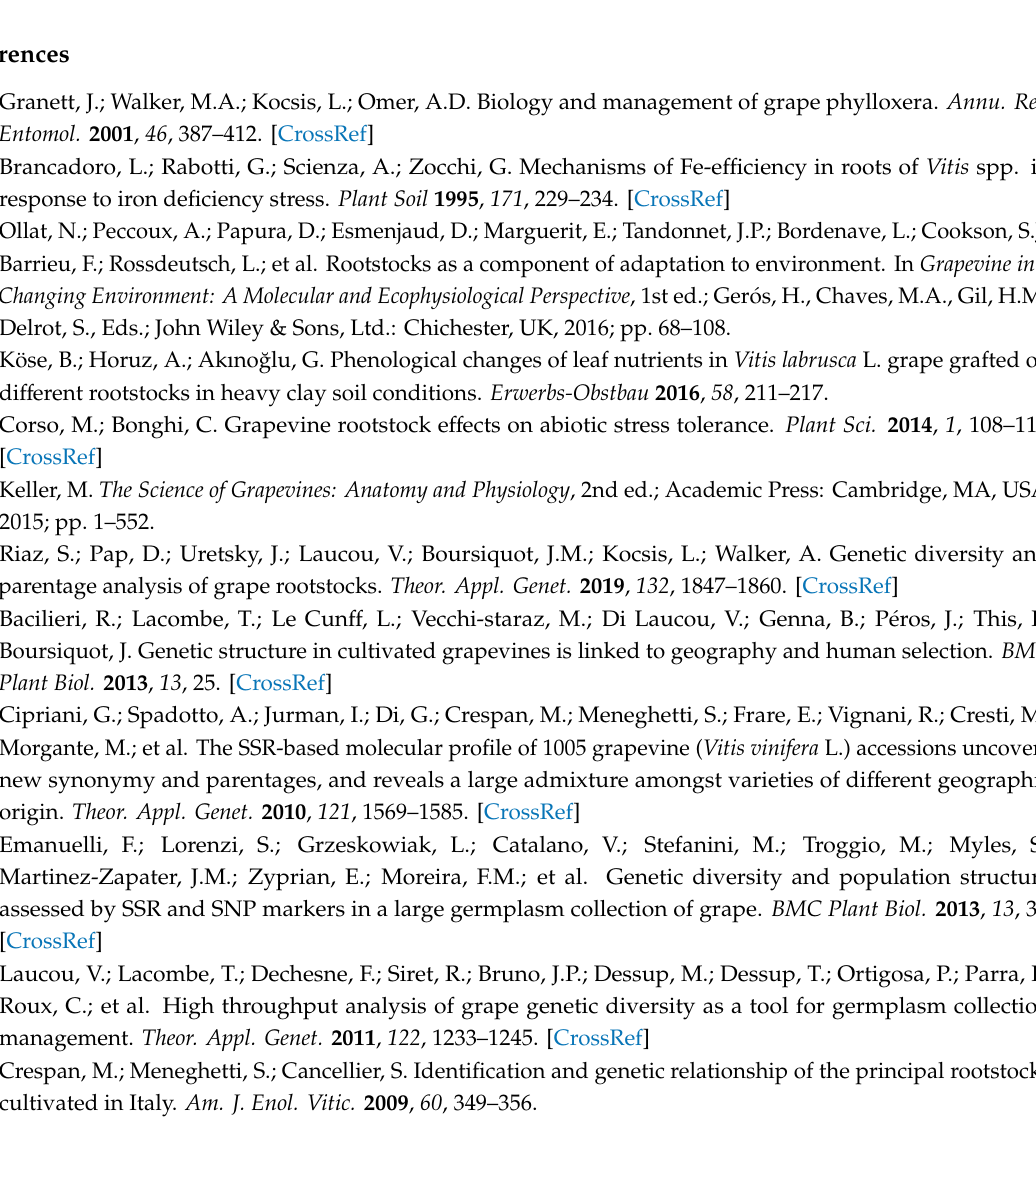
Table S1: SNP profiles of 66 non- vinifera rootstock accessions, genotyped at 18 K loci. Original dataset was filtered based on SNP call quality (p50GC < 0.54), GenTrain score ( > 0.6), and monomorphic loci, resulting in 14,180 SNP loci. “A”: homozygous for dominant allele; “B”: homozygous for recessive allele; "H": heterozygous; “U”: missing data. Table S2: Ancestry values at K = 4 and K = 3 for SNP and SSR profiles, respectively, of 66 non- vinifera rootstock